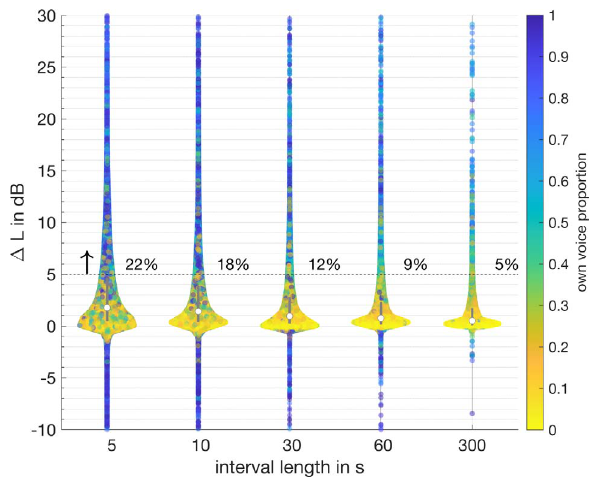
Figure 6. In fl uence of OVS exclusion on the mean A-weighted SPL in half-overlapping analysis intervals with different interval lengths for all participants and recording days. The color indicates the proportion of OVS in each interval. The median level difference is represented by the white dot and the interquartile range by the grey area. The percentages on the dashed line indicate the proportion of SPL differences greater than 5